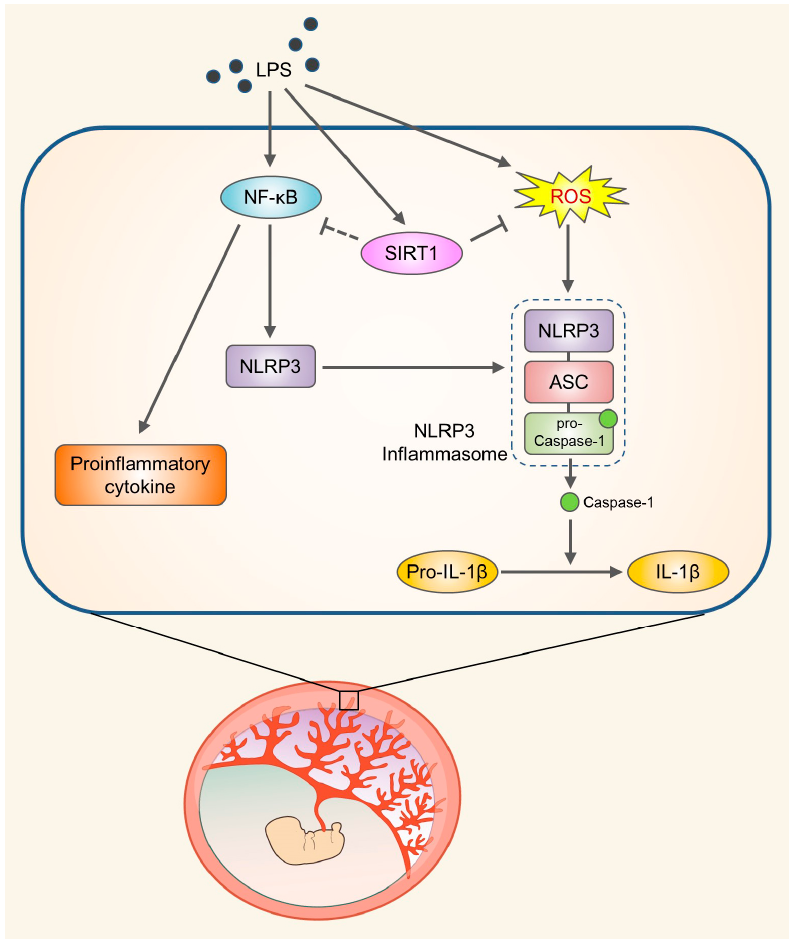
Figure 7. Schematic diagram illustrating the role of SIRT1 in trophoblasts upon exposure to LPS. SIRT1 not only attenuates LPS-induced NLRP3 inflammasome activation but also inhibits inflammatory response and IL-1 β secretion by reducing oxidative stress.